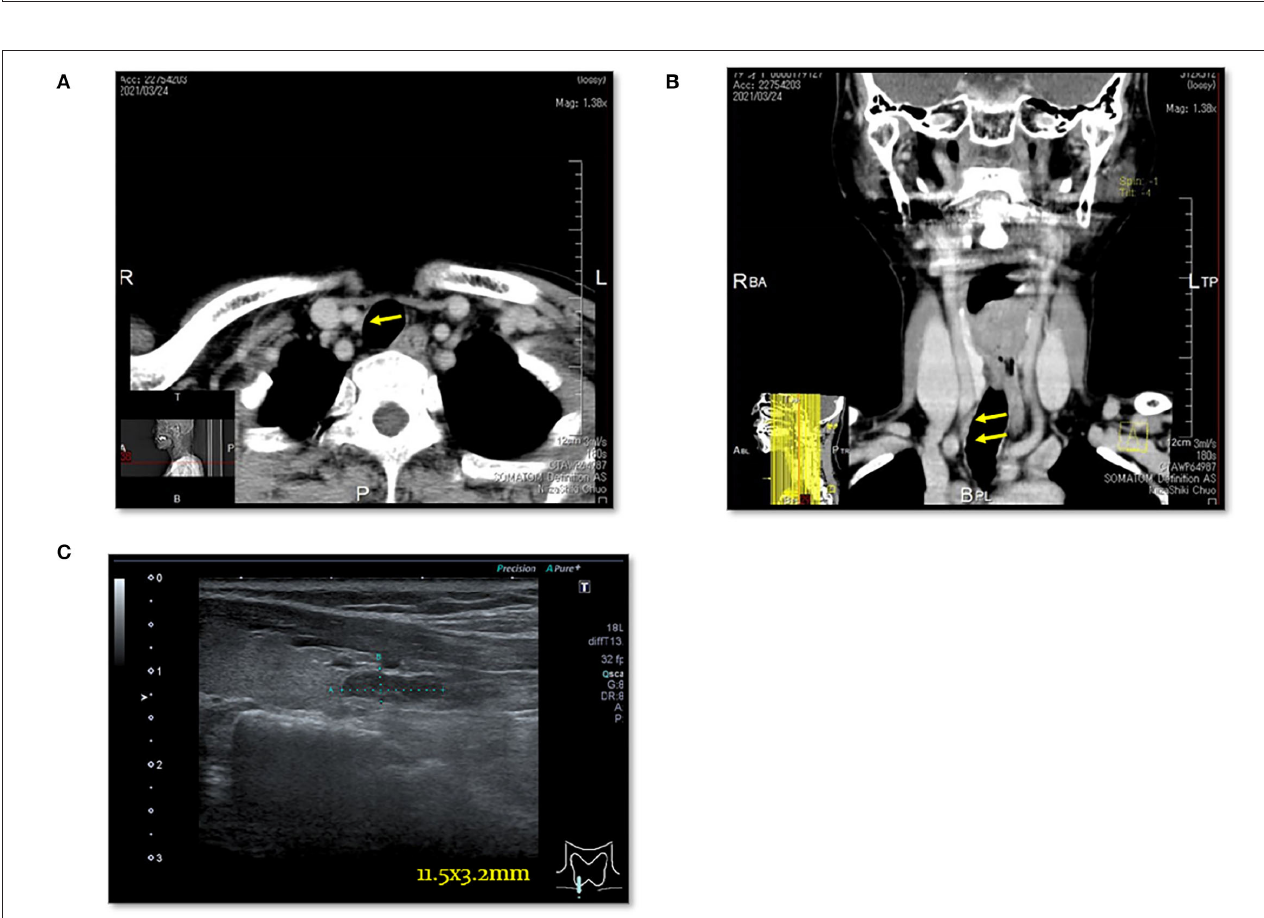
FIGURE 6 | Case 8. (A) Thoracic enhanced CT scan showing a mass (EPA: yellow arrow) near the right trachea. (B) Thoracic enhanced CT (MPR) scan showing a mass (EPA: yellow arrow) near the right trachea. (C) Cervical neck ultrasound showing a mass [11.5 × 3.2mm (EPA)] near the cervical esophagus.